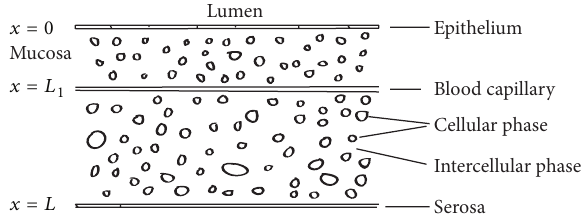
Figure 1: Schematic diagram of the intestinal